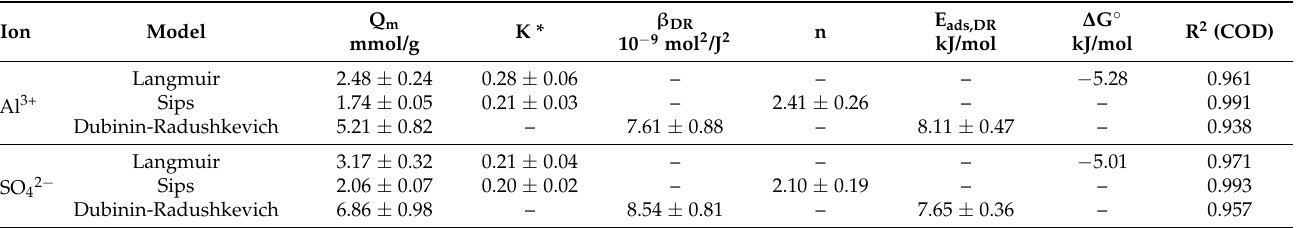
Figure 6. ( a ) Adsorption capacity for Cd 2+ (filled squares) and SO 42 − (crossed circles) from a CdSO 4 solution at the respective equilibrium concentrations c eq with the corresponding Sips isotherm model fits (a blue, solid line for Cd 2+ , and a dashed line for SO 42 − ). The corresponding pH values for the experiments can be seen at Figure S19. ( b – e ) SEM-EDX image and mapping of H-Ch60-2 after the adsorption experiment with CdSO 4 solution (c 0 = 800 mg/L Cd 2+ ). ( b ) SEM image of H-Ch60-2 after the adsorption with CdSO 4(aq) . ( c – e ) SEM-EDX elemental mapping of ( c ) Cd (green) and S (yellow), ( d ) Cd (green), and ( e ) S (yellow). The corresponding EDX spectra are shown in Figure S21. The SEM-EDX and SEM images for H-Ch60-2 before the adsorption process are shown in Figure S8. Table 4. Fitting parameters for Langmuir, Sips and Dubinin–Radushkevich isotherm models for the adsorption from a CdSO 4 solution. Here, Q m is the maximal sorption capacity, K is the equilibrium constant for the respective model, n is the Sips isotherm model exponent, and E ads,DR is the mean free energy of adsorption derived from the Dubinin–Radushkevich model. R 2 corresponds to the coefficient of determination